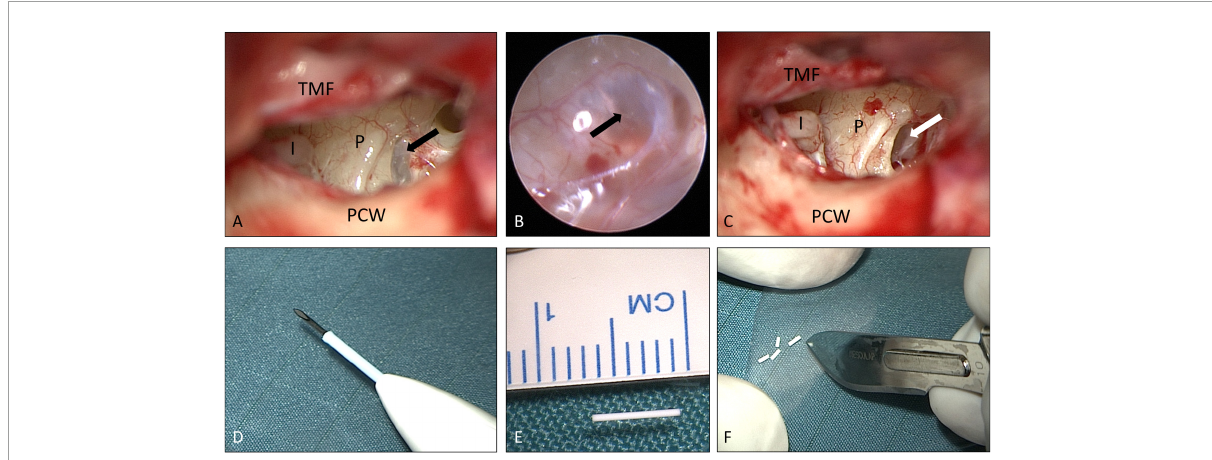
FIGURE1 Surgical procedure: (A–C) tympanoscopy and removal of "false RWM” (patient No. 9, right ear). The black arrows show a mucosal membrane (“false RWM”) covering the RW niche. The white arrow shows the RWM after removal of a mucosal membrane. (D–F) Preparation of implant. The drug delivery system (0.46 × 6 mm) was unloaded (E) from the injection device for intravitreal delivery (D) and cut into approximately equal pieces of 1.5 mm each (F) . See also Supplementary video material . I: long process of incus (distal end); P: promontory; PCW: posterior canal wall; TMF: tympanomeatal flap. (A,C–F) Microscopic images; (B) endoscopic image, 1.7 mm, 30 ◦ ). Figures (A–C) after Plontke (2018) with